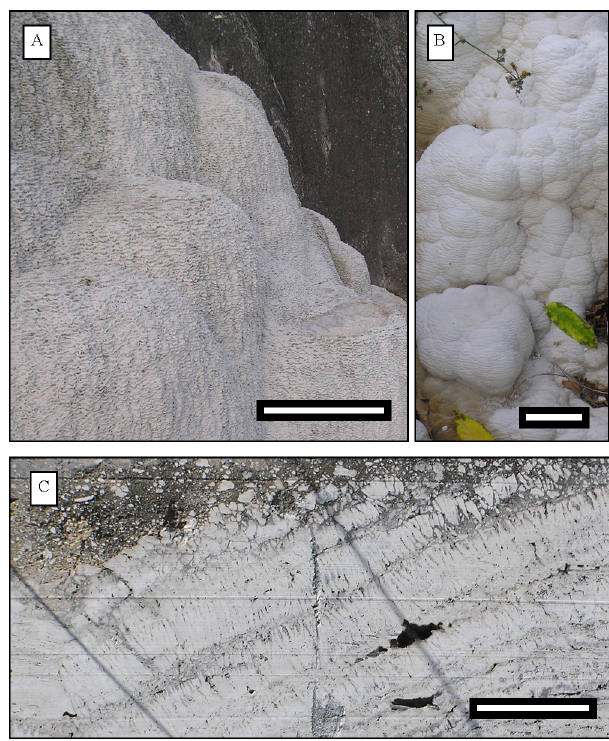
Figure 4. High temperature and ∆ G r . (A) Travertine build-up at the outflow point from the spar pool. Steep gradient microterracettes are typical of the deposit. Scale bar is 1m long. Terme San Gio- vanni, Tuscany, Italy. (B) Crystalline calcium carbonate in botry- oidal masses lining an outflow channel. Scale bar is 100mm long. Terme San Giovanni, Tuscany, Italy. (C) Palisade calcite growing normal to substrate within a Holocene travertine site. The sequence is capped by a palaeosol. Scale bar is 300mm long. Terme San Gio- vanni, Tuscany, Italy.